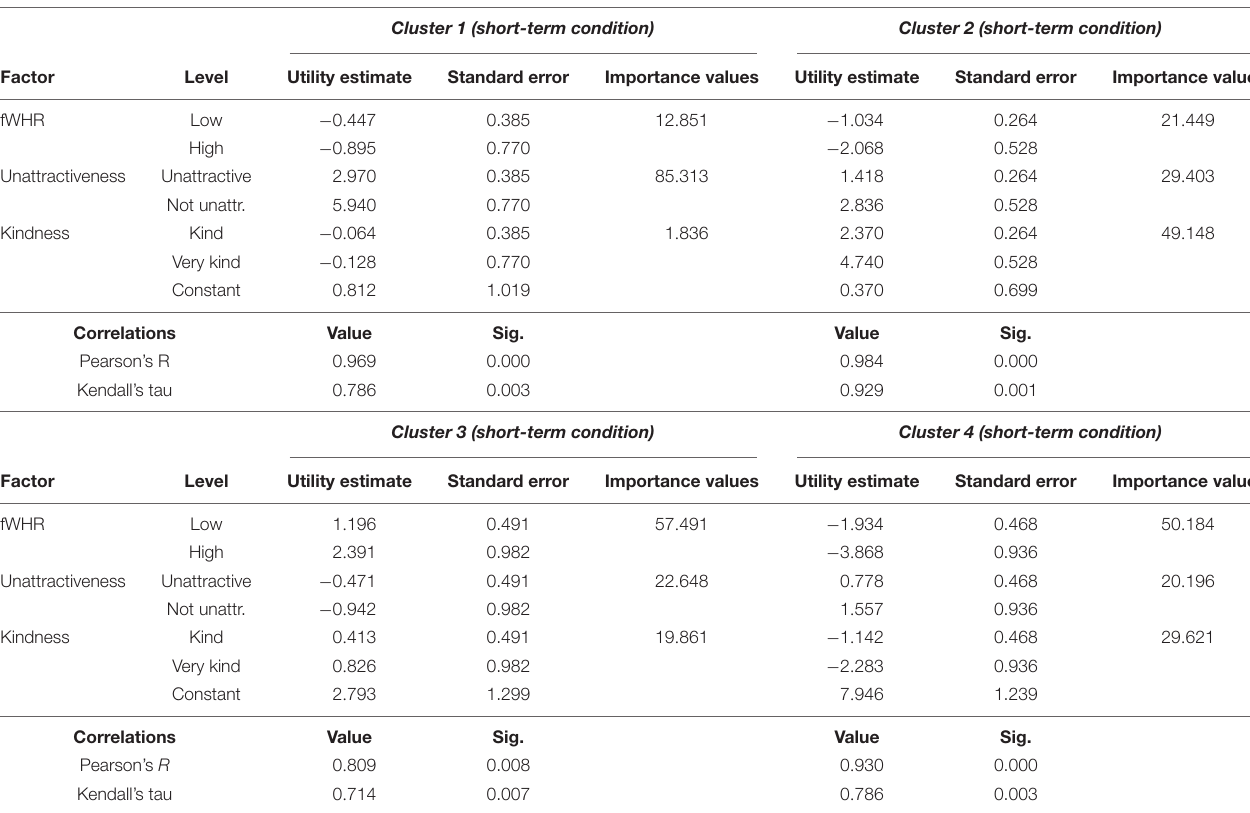
TABLE 4 | Results conjoint analysis by cluster (unobserved heterogeneity analysis).